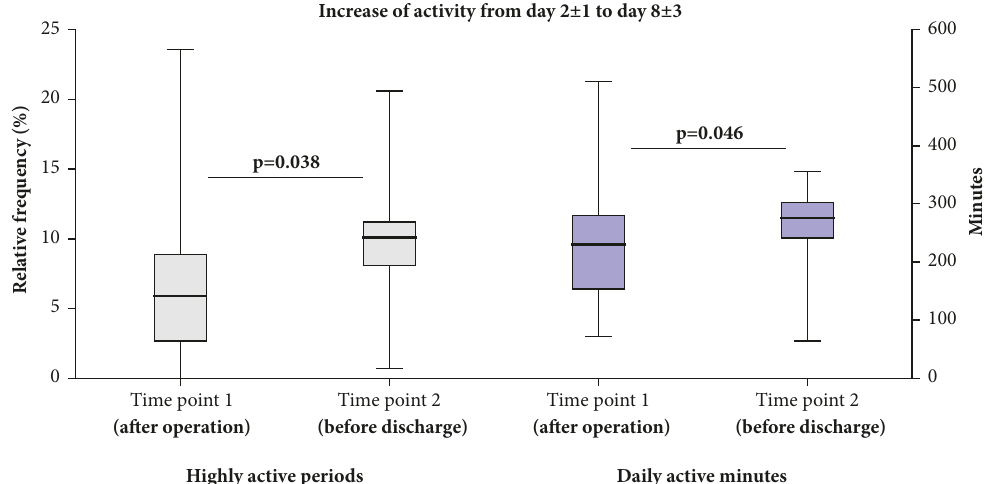
Figure 6: After an operation for stabilization of the proximal femur, the activity is increasing during the first couple of days. This can be measured using an Axivity tracker and calculating the highly active periods (category 4) per day (%, left) or the active minutes per day (right).